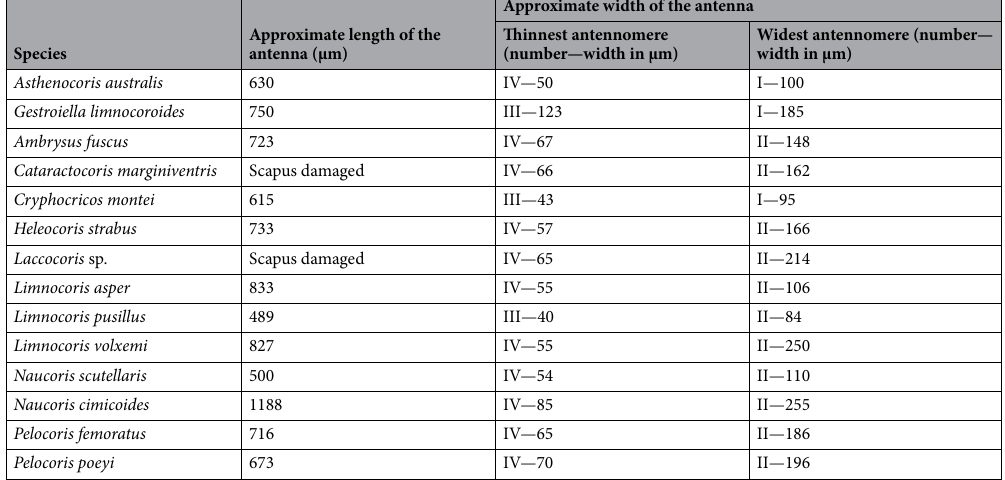
Table 1. The data of the size of some antennomeres in studied